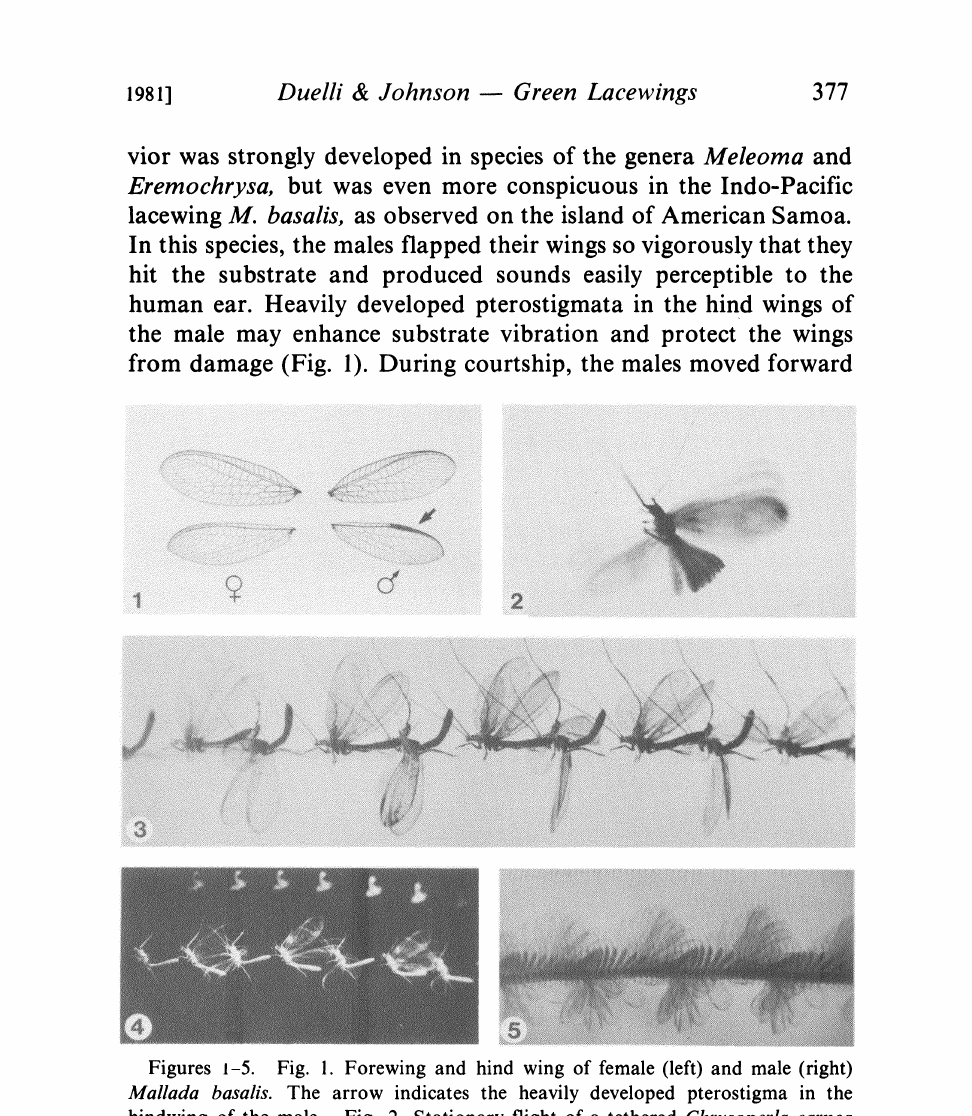
motion. Fig. 3. Chrysoperla carnea male mounted horizontally on a flight mill. Strobe flashes (54 Hz) show the exact antiphase of abdominal and wing vibration. Fig. 4. Chrysoperla carnea male mounted on a flight mill in "natural" flight position as shown in figure 2. Any forced deviation from the "natural" body angle leads to an increased amplitude of the abdominal vibration (See figure 3 for comparison). Fig. 5. Same specimen and same position as in Fig. 3. 400 Hz strobe flashes show the full flow of the movements of wings and